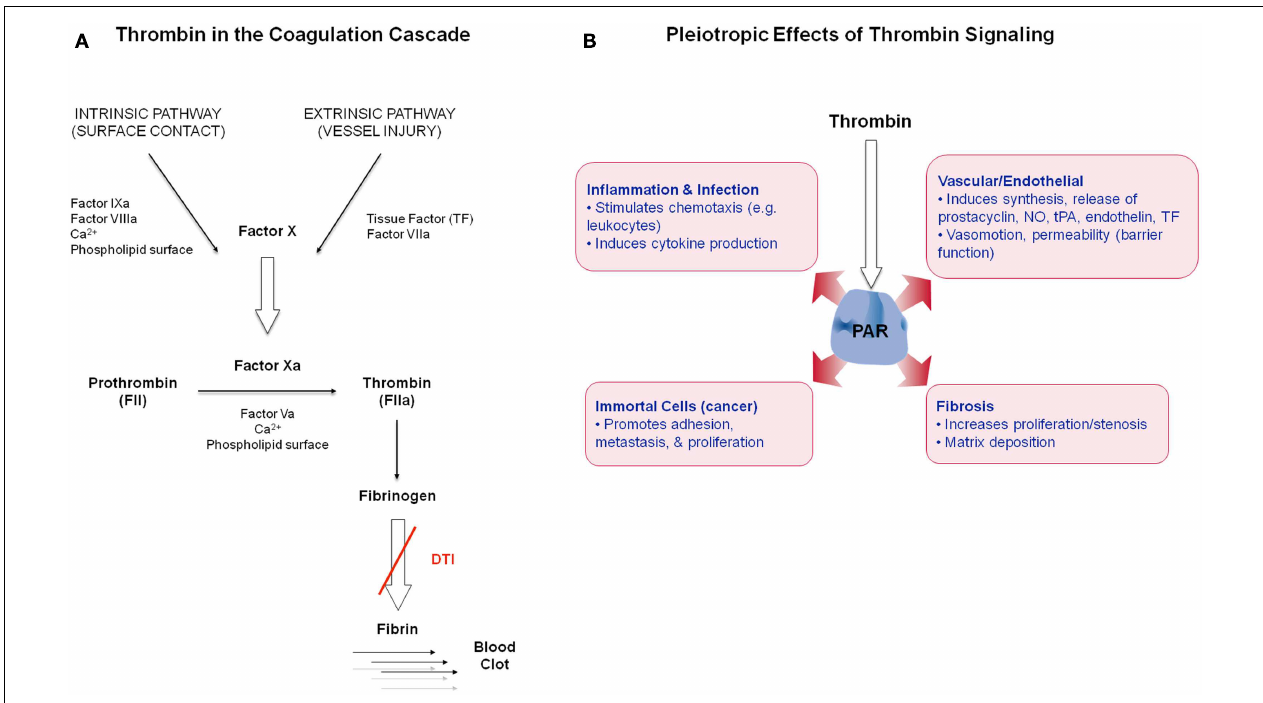
FIGURE 1 | (A) Simplified schematic of thrombin in the coagulation cascade. (B) Overview of thrombin’s non-hemostatic effects via PAR receptor signaling in diverse cell types.